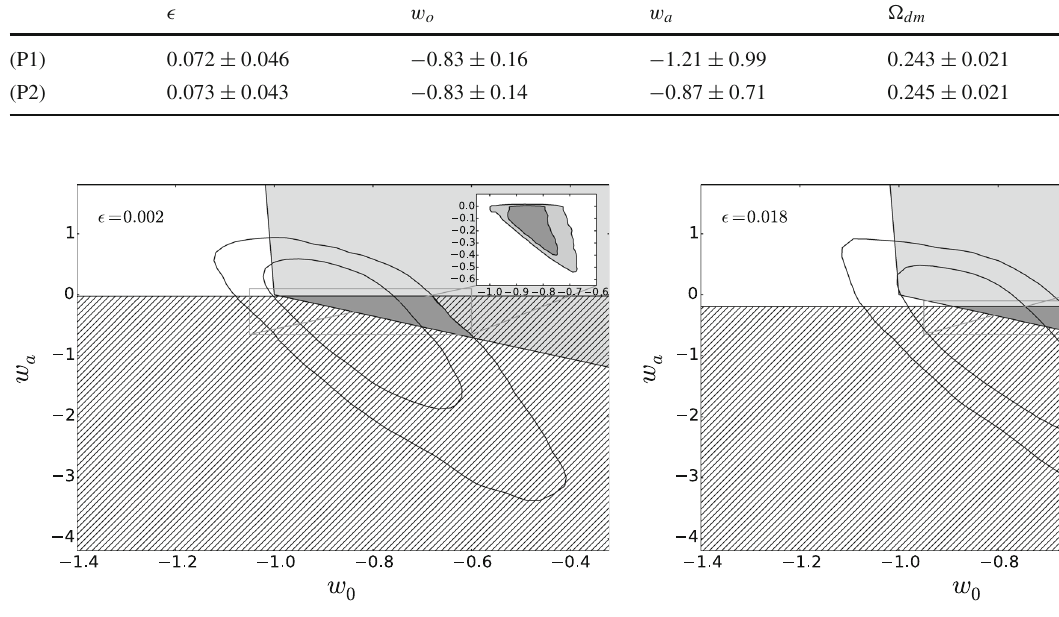
panel for (cid:7) = 0 . 018. The dark triangle corresponds to the combined allowed region. The subplot in each panel shows the confidence con- tours obtained by introducing the thermodynamical restrictions in the prior distribution π((cid:11)) to perform the statistical analysis